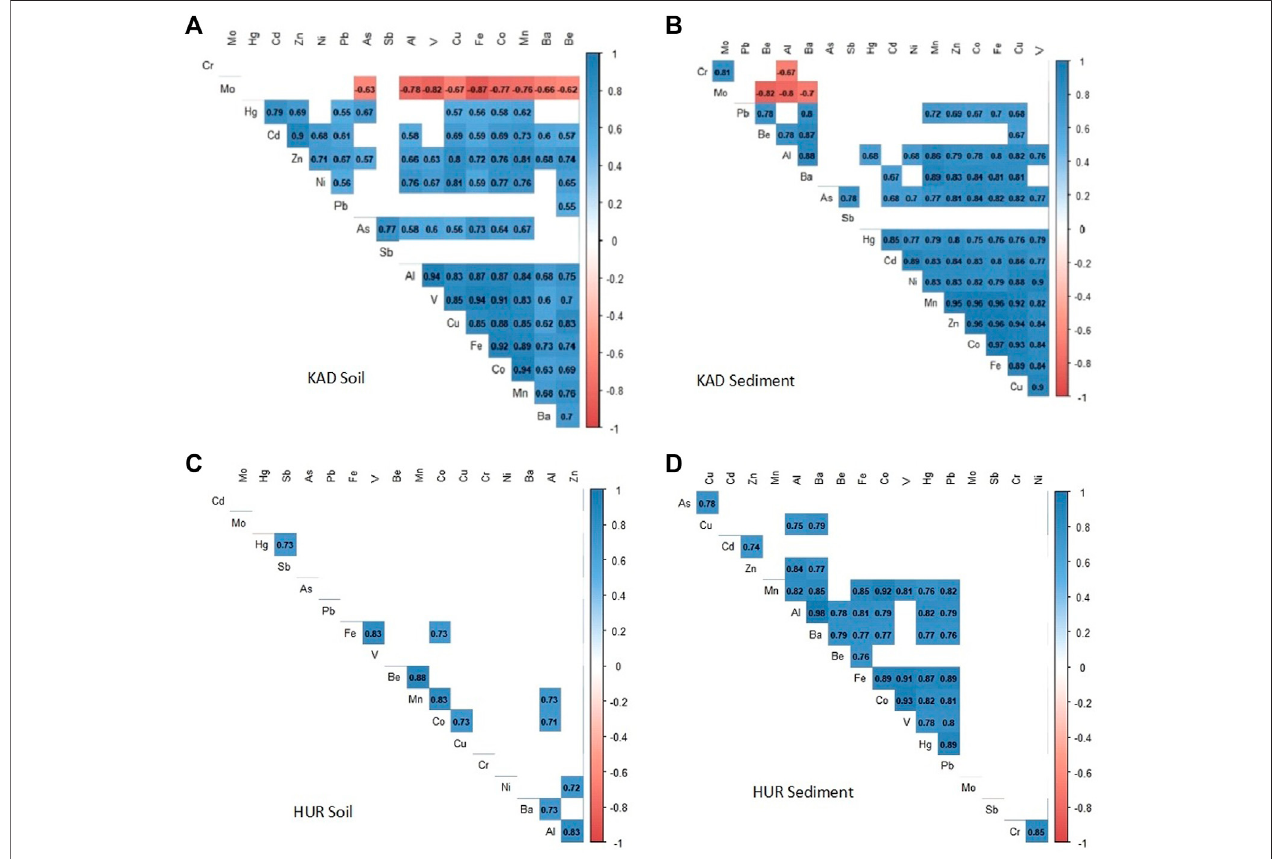
FIGURE7| SpearmanRank ’ scorrelationanalysisplotsforPHEsinsoils (A and C) andstreamsediments (B and D) wherebluerepresentspositivecorrelation,red negative and a blank space denotes no existing correlation. p < 0.05.